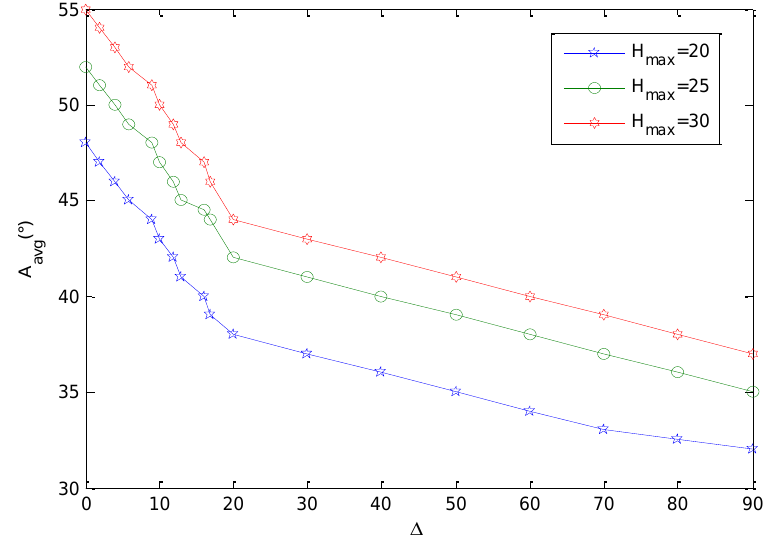
Figure 7. Relationship between elevation angles at different HAPS altitudes.